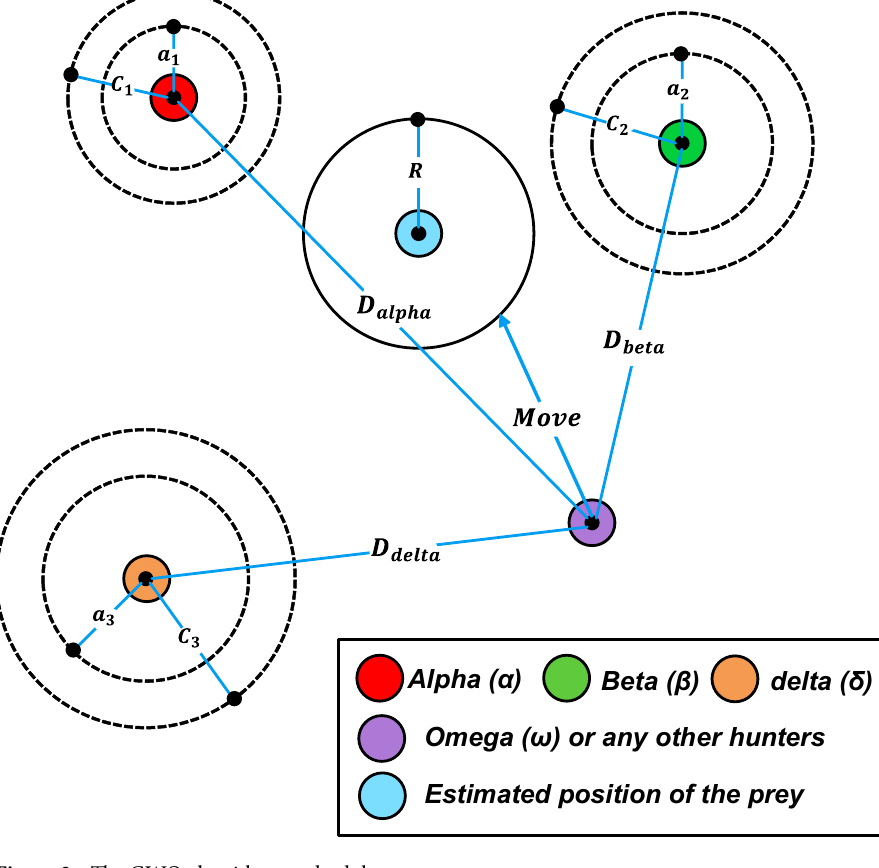
Figure 3. The GWO algorithm